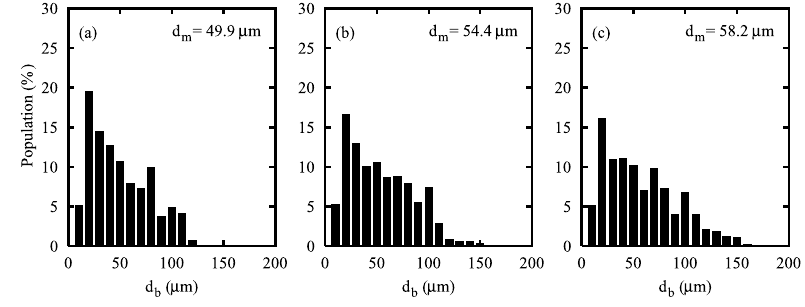
Fig. 6 Distribution of populations of bubbles for di ff erent values of Q a (a) 0.5 (cid:3) / min, (b) 0.250 (cid:3) / min and (c) 0.4 (cid:3) /